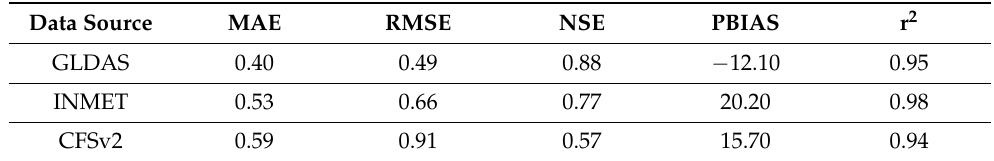
Table 2. Validation of ETa based on SSEBop-Br model for the three sources of meteorological data available.